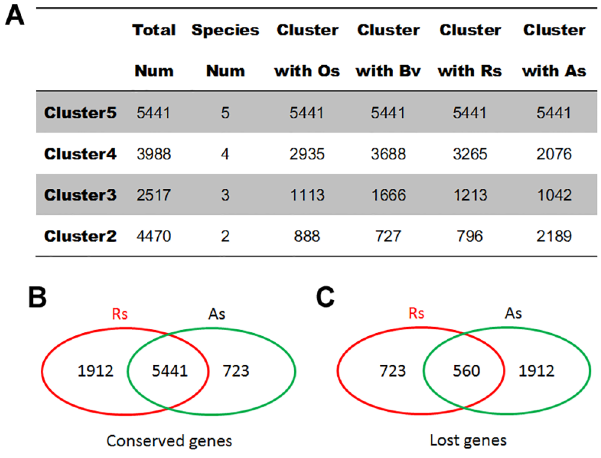
Fig 2. Genes conserved and lost in R . soongorica and sand rice. (A) Four kinds of Clusters with different numbers of orthologs are showed. In particular, 4470 sub-clusters were assigned into Cluster2, of which 888 sub-clusters contained the A . thaliana and O . sativa genes; (B-C) A total of 5,441 genes were conserved and 560 genes were lost in both R . soongorica and sand rice. Meanwhile, 1912 genes were conserved in R . soongorica but lost in sand rice, whereas 723 genes were conserved in sand rice but lost in R . soongorica . Os, O . sativa ; Bv, B . vulgaris ; Rs, R . soongorica ; As, A . squarrosum .